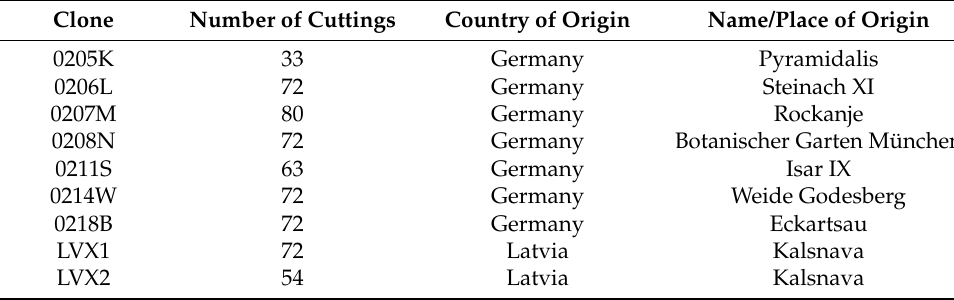
Table 1. Salix alba clone origin and number of cuttings. Clone Number of Cuttings Country of